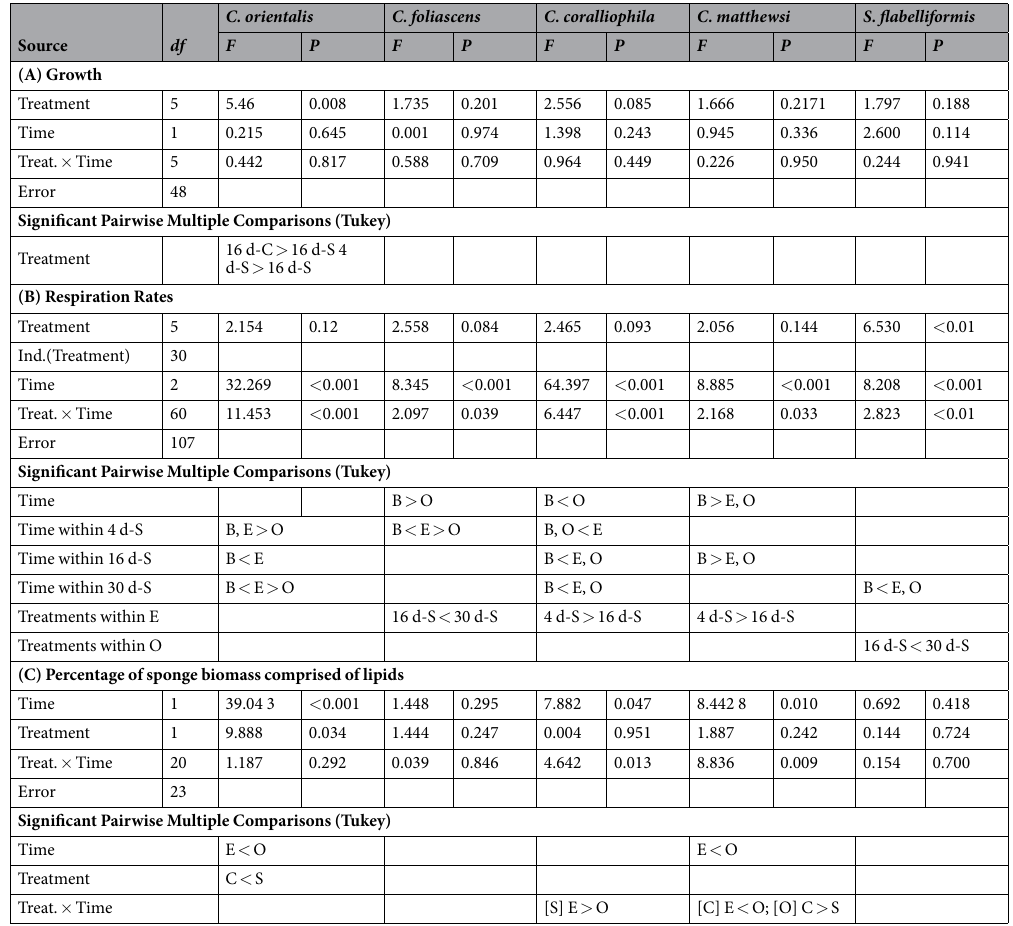
Table 1. ANOVA tables and summaries of linear mixed models testing the effects of smothering on the physiological responses of sponges. (A) Percent growth rate based on thickness measures, (B) Respiration rates and (C) Percentage of sponge biomass comprised of lipids. Tukey tests have been performed for significant pairwise multiple comparisons. Abbreviations: ‘B’ for before sediment pulse (T = 0), ‘E’ for end of experimental phase, ‘O’ for end of observational period, ‘C’ for controls, ‘S’ for smothered, and ‘4 d’, ‘16 d’ and ‘30 d’ for time